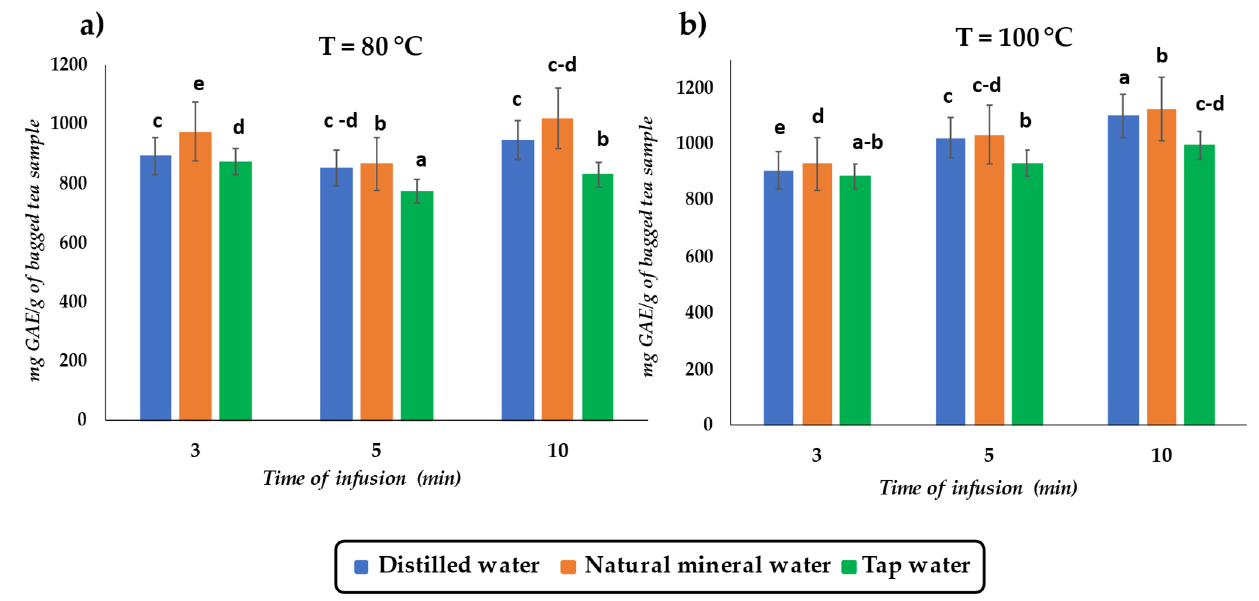
Figure 3. Total phenolic content (TPC) in green tea samples (mg GAE/g). ( a ) TPC for green tea infusion at T = 80 °C for different infusion times and types of water; ( b ) TPC for green tea infusion at T = 100 °C for different infusion times and types of water. Error bars are ± standard deviation. Same letters indicate a significant difference according to the ANOVA test ( p < 0.05).